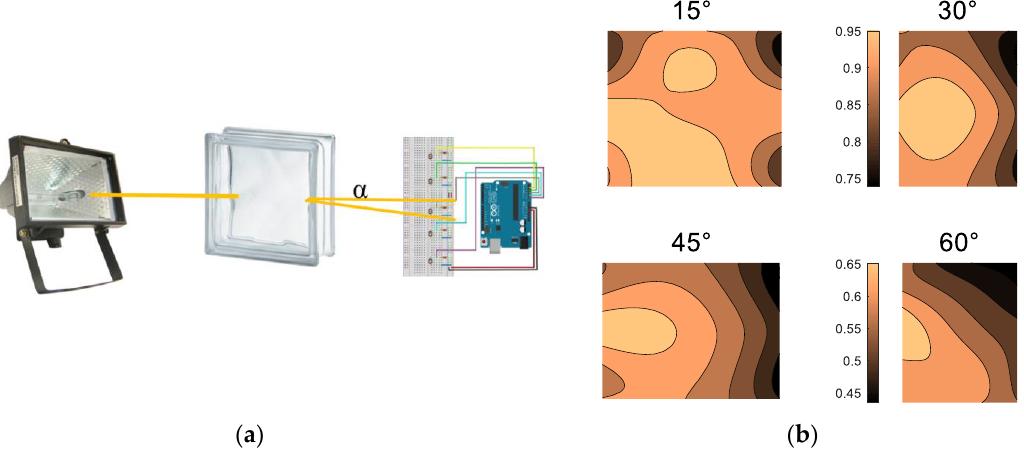
Figure 13. Glass block surface shaded areas in the laboratory. Two color maps refer to the 15° and 30° inclinations, and 45° and 60° respectively. The first image shows how, by moving the position of the lamp, the effects of borders are concentrated on the edges: ( a ) scheme used for the characterization of the glass block, the angle α varies during the measurements; ( b ) evaluation of the shading in different configurations.